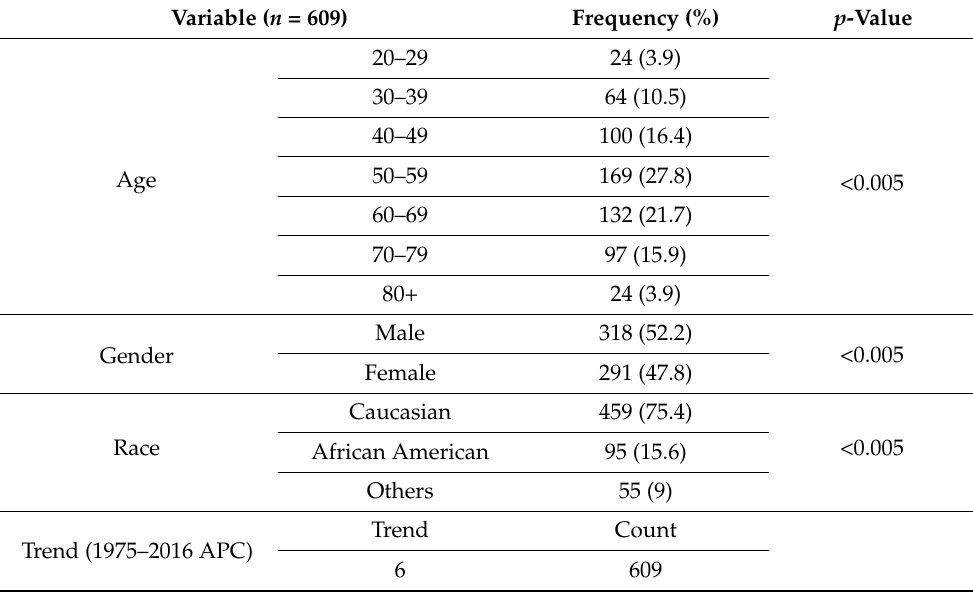
Table 1. Demographic profiles of 609 patients with parathyroid cancer from the Surveillance, Epi- demiology, and End Results (SEER) database,